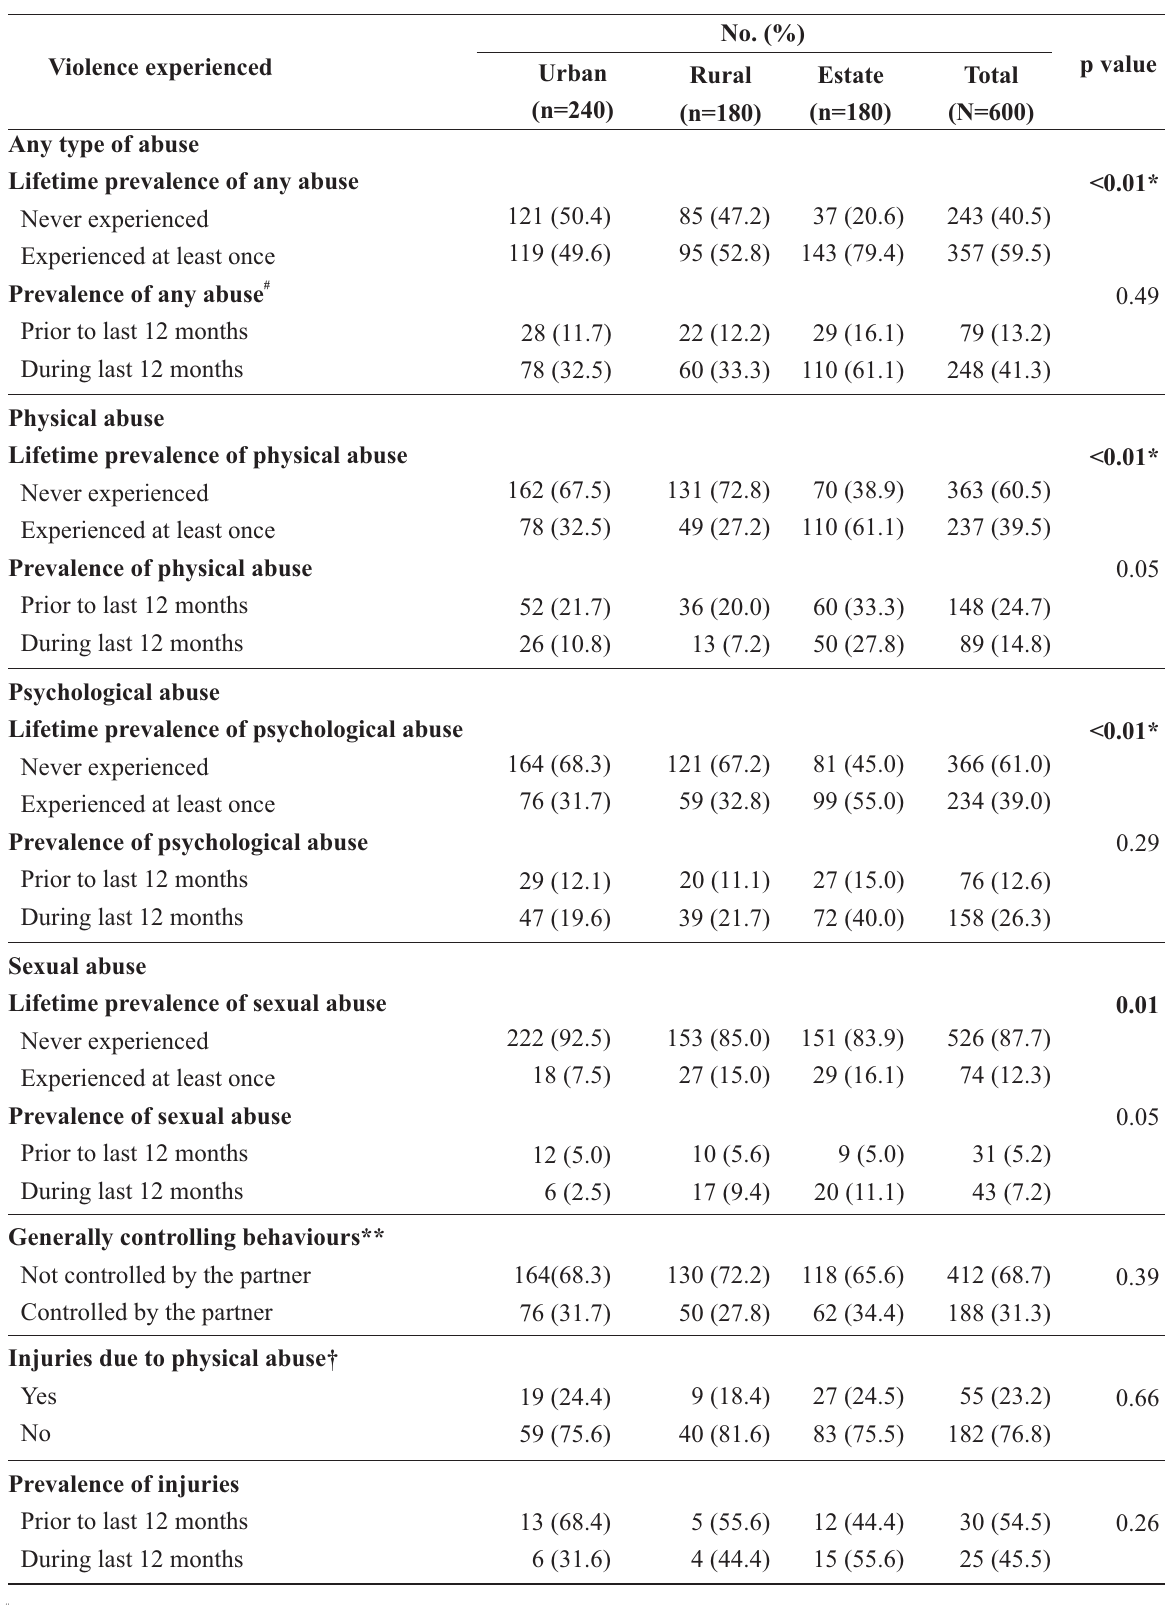
Table 2: Prevalence of abuse experienced by women in urban, rural and estate sectors